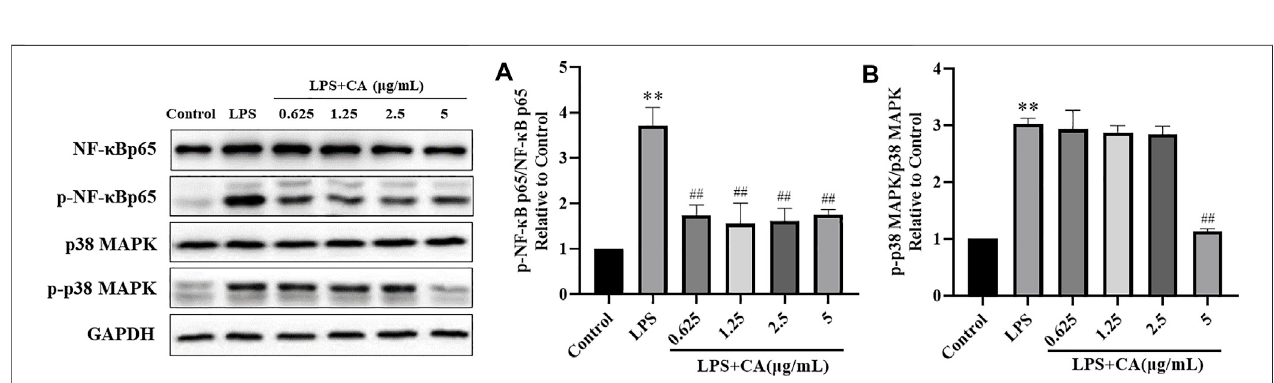
FIGURE10| Theproteinexpressionofp-NF- κ Bp65 (A) andp-p38MAPK (B) .CellswerepretreatedwithorwithoutvariousconcentrationsofCAfor2h,andthen co-incubated with or without LPS (1 μ g/ ml) for 24 h. The levels of protein expression were detected by western blotting. * p < 0.05, ** p < 0.01 vs . control group; ## p < 0.01 vs . LPS